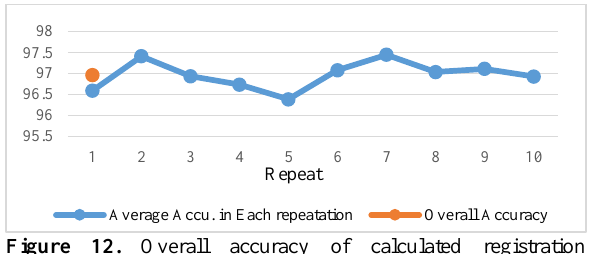
Figure 12. Overall accuracy of calculated registration parameters (percent).